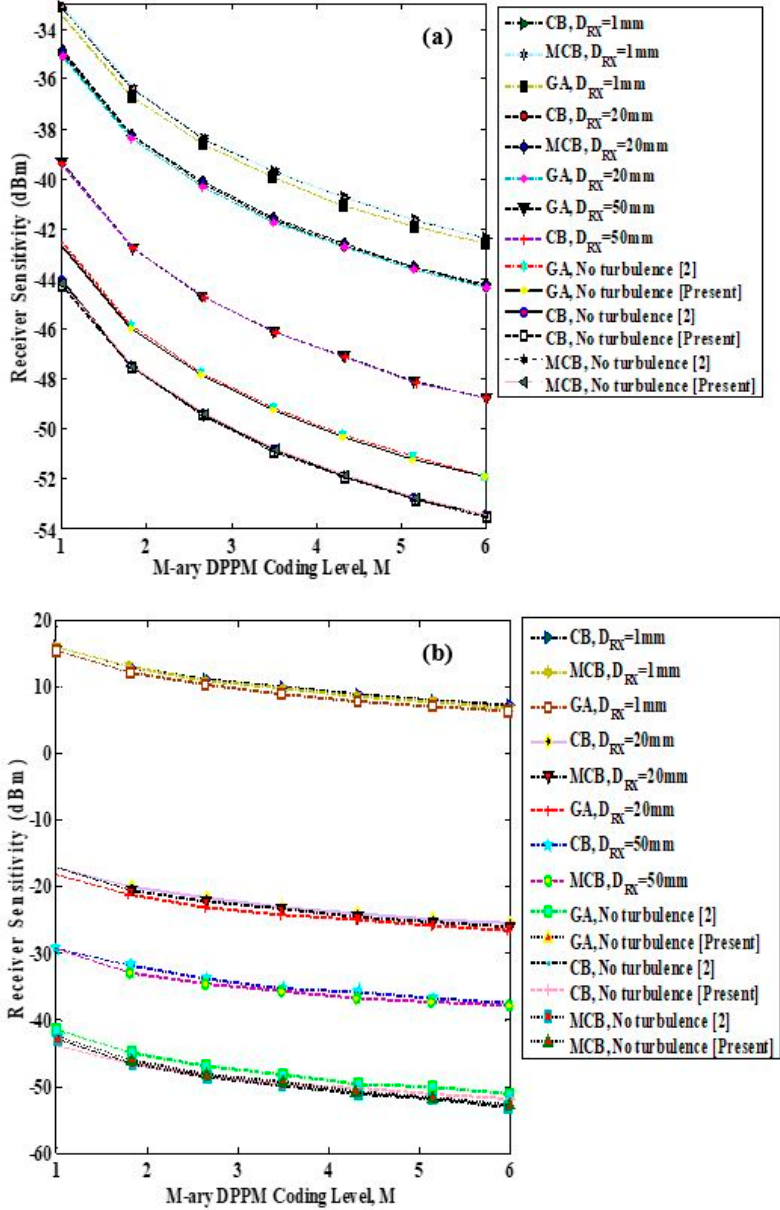
Figure 4. Receiver sensitivity (RS) (dBm) versus M-ary DPPM coding level is presented for the NT with ( a) WT condition and (b) ST is demonstrated in [2], [present].